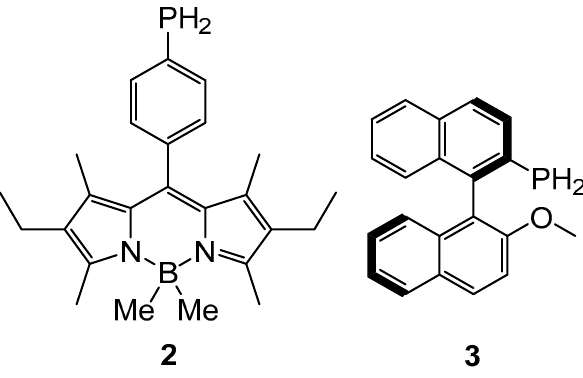
Figure 1. Examples of air-stable primary phosphines.